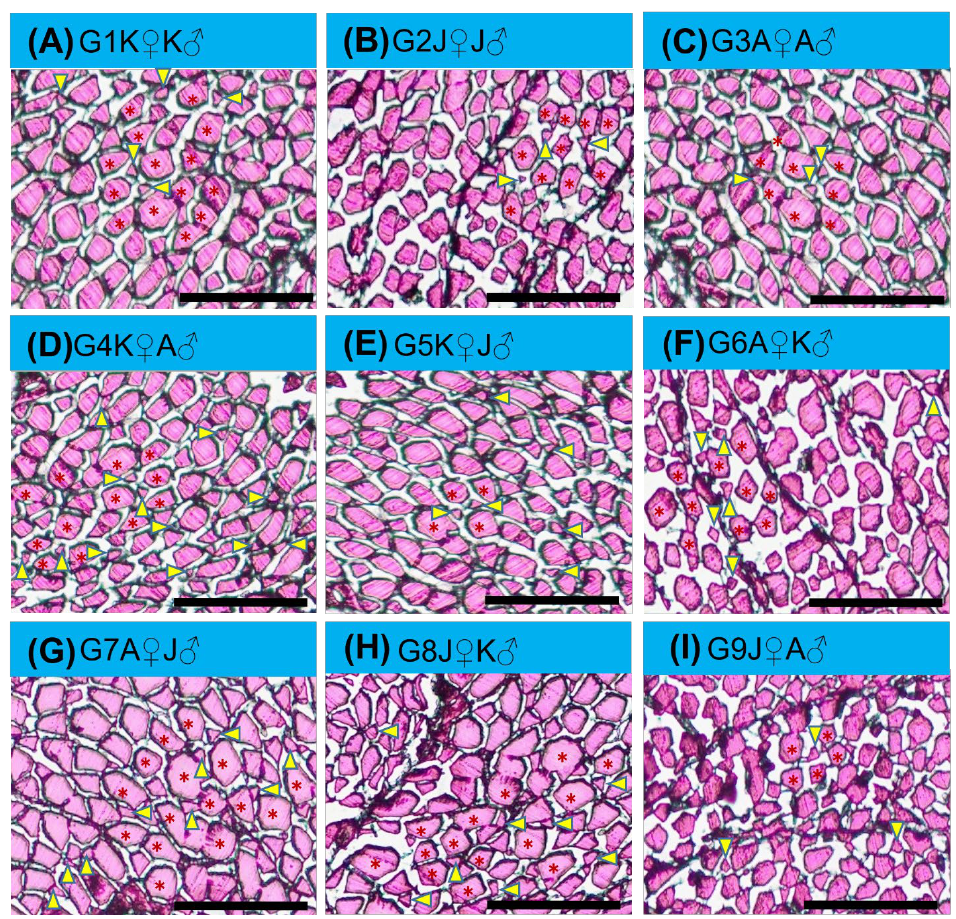
Figure 4. Muscle morphometrical variation of different crossbred groups of Ariza labeo ( L. ariza ) F1 generation. [( A ), ( B ), ( C ), ( D ), ( E ), ( F ), ( G ), ( H ) and ( I ) represent G1K ♀ K ♂ , G2J ♀ J ♂ , G3A ♀ A ♂ , groups, respectively. The single words picked to name the purebred and crossbred groups bear the full forms as G → Group, K → Kangsha River stock, J → Jamuna River stock and A → Atrai River stock. Recruited myofibers (hyperplastic) are smaller (yellow arrowheads indicated) situated between the medium and large diameter muscle fiber (red asterisk mark indicated)]. Scale bar = 50 µ